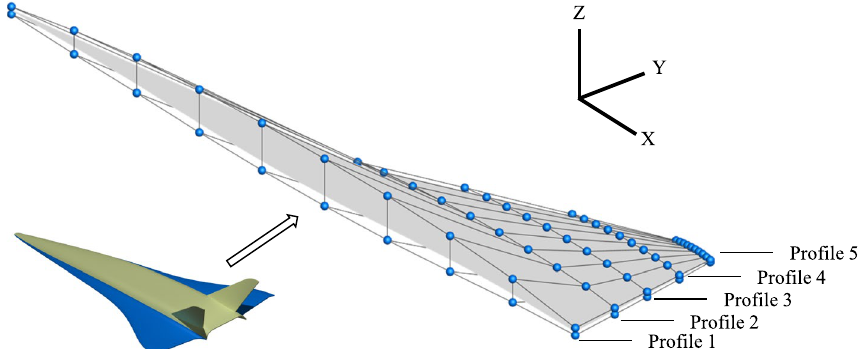
Fig. 7 Schematics of FFD control points in five wing profiles of the Sanger aerospace plane carrier wing